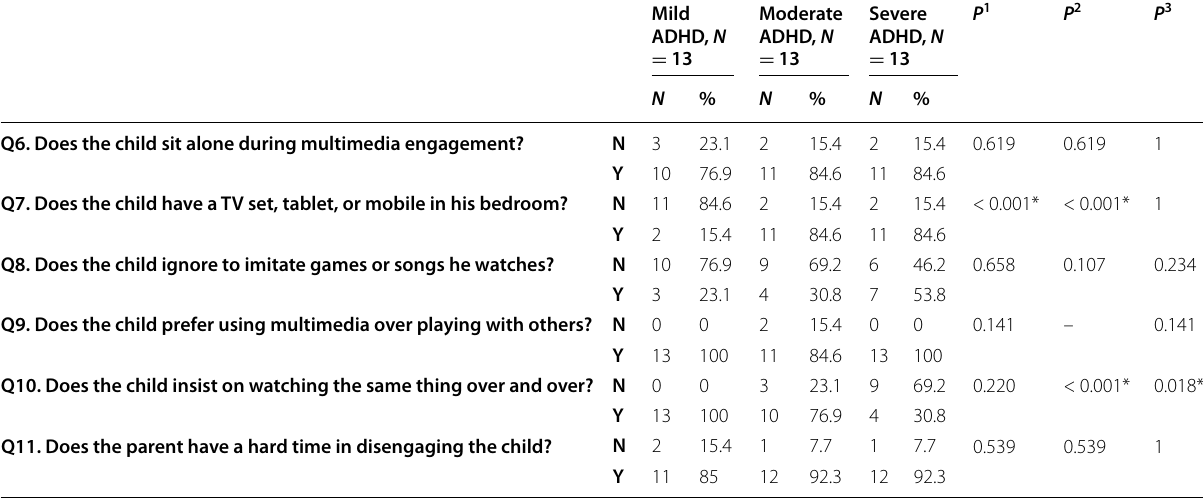
P 1 , comparison between mild ADHD and moderate ADHD; P 2 , comparison between mild ADHD and severe ADHD; P 3 , comparison between moderate ADHD and severe ADHD. Categorical data are expressed as numbers and percentages, compared by the chi-square or Fisher exact